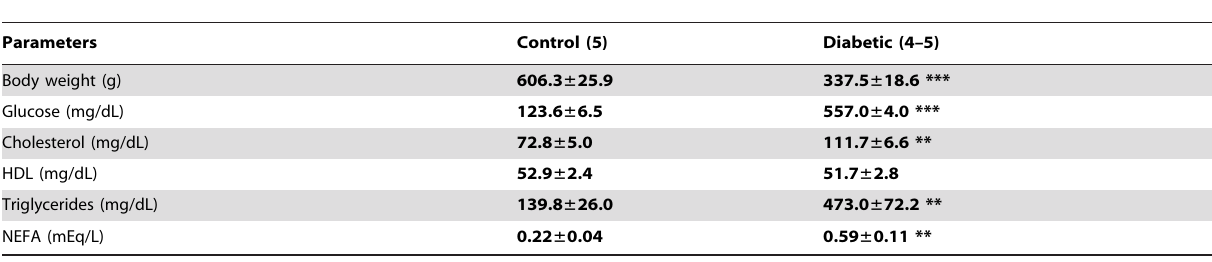
Table 1. Values of various parameters in diabetic and control rats.